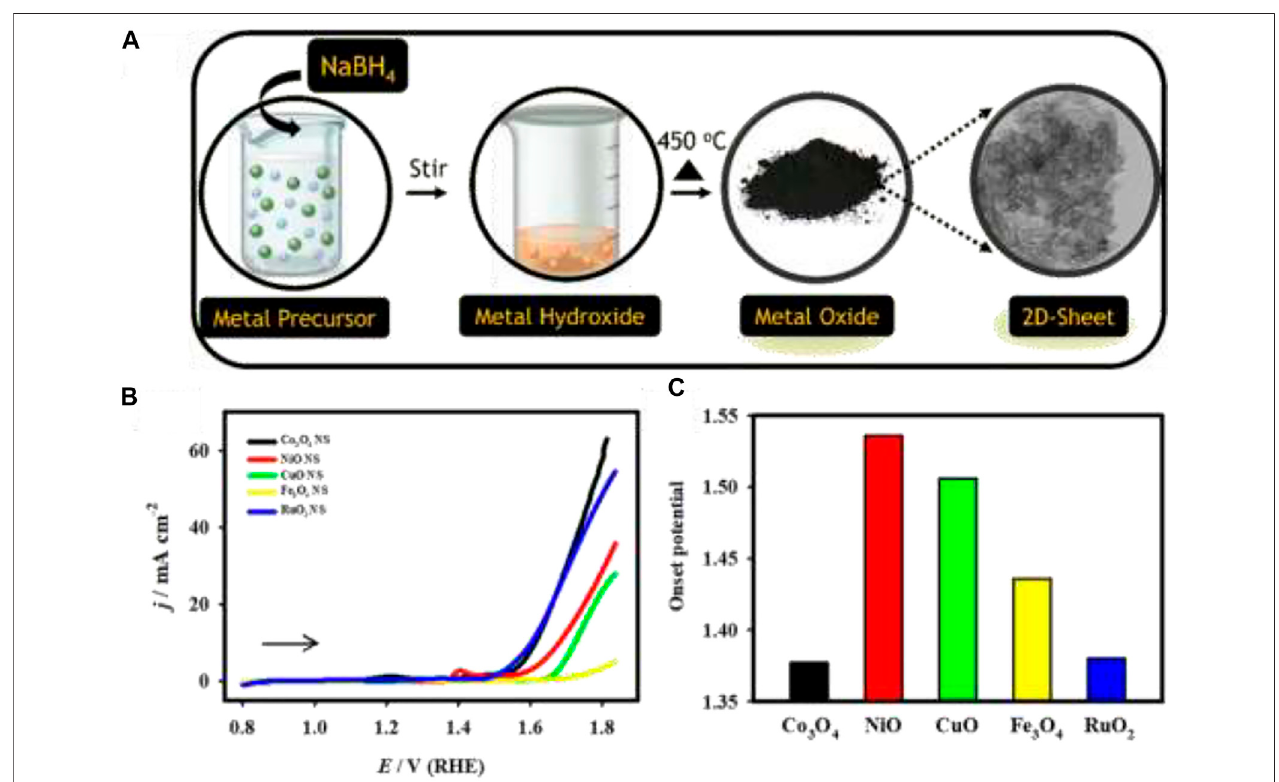
FIGURE 5 | (A) Schematic illustration of the synthesis of 2d-metal oxide nanosheets, (B) LSV curves of the Co 3 O 4 (black), NiO (red), CuO (green), Fe 3 O 4 (yellow), and RuO 2 (blue) electrodes recorded in 1.0 M KOH at a scan rate of 20 mV s − 1 . (C) Plot of the OER onset potential: Reprinted (adapted) with permission from Elakkiya and Maduraiveeran (2020). Copyright 2020 American Chemical